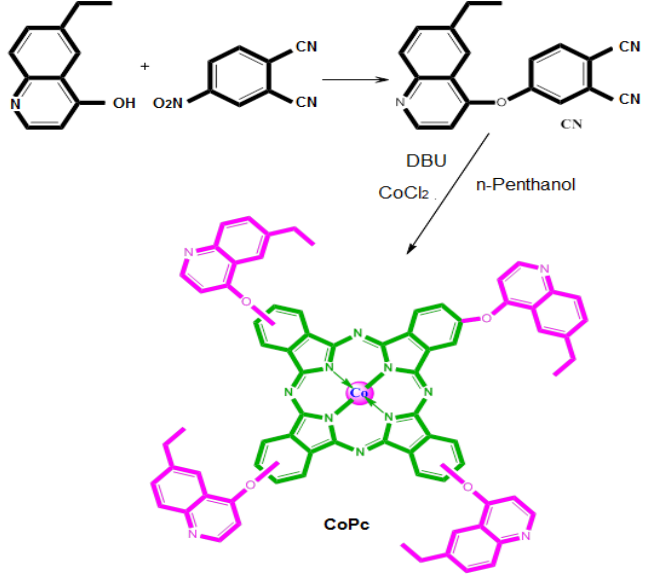
Figure 3. Synthesis stages of CoPc.